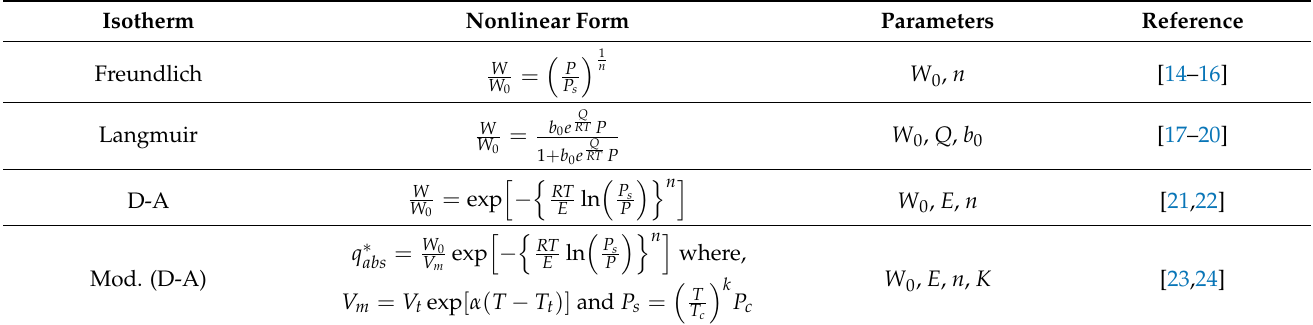
Table 1. Non-linear adsorption isotherms models, parameters, and references. Isotherm Nonlinear